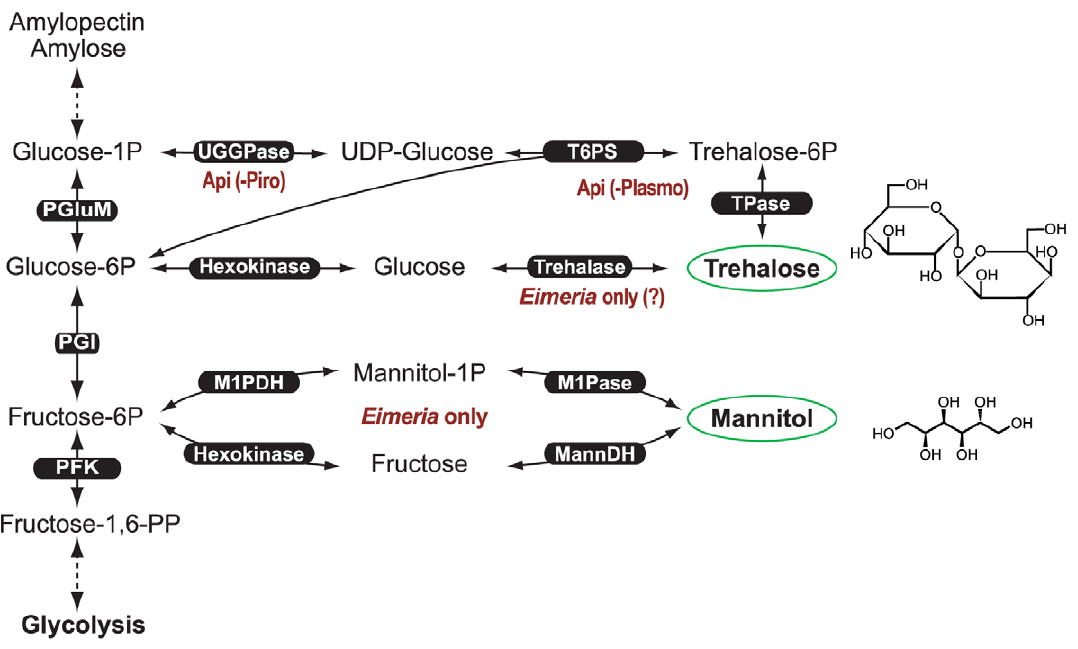
Figure 1. Presence of trehalose synthetic pathway in the apicomplexans as determined from available genome sequences. Within the pathway, UDP-glucose/galatose pyrophosphorylase (UGGPase) is present in almost all apicomplexans with the exception for piroplasmids (e.g., Theileria and Babesia ) [marked as Api(-Piro)], while trehalose-6P synthase and trehalose phosphatase (TPase) are fused as a bifunctional protein that is present in all apicomplexans with the exception for Plasmodium species [marked as Api(-Plasmo)]. Trehalase may only be present in the intestinal coccidia ( Eimeria ). For comparison, the mannitol cycle present only in the intestinal coccidia (represented by Eimeria tenella ) is also illustrated.